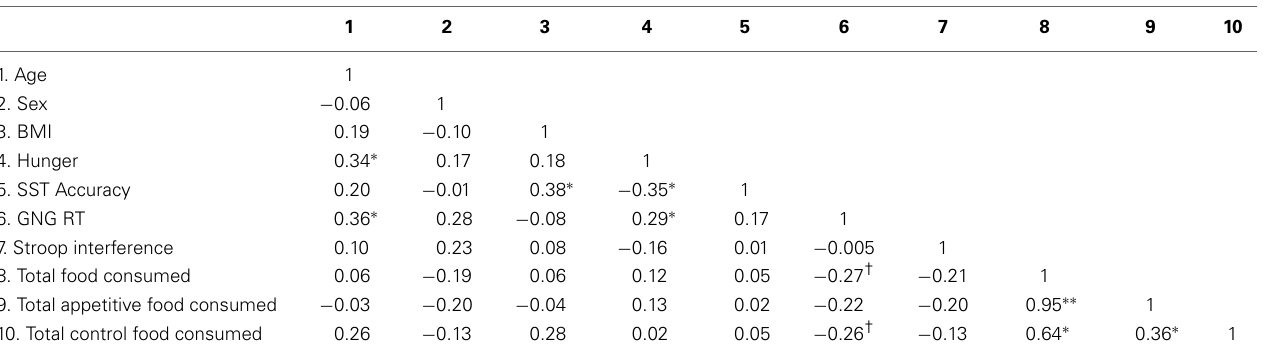
Table 2 | Correlations between measures.